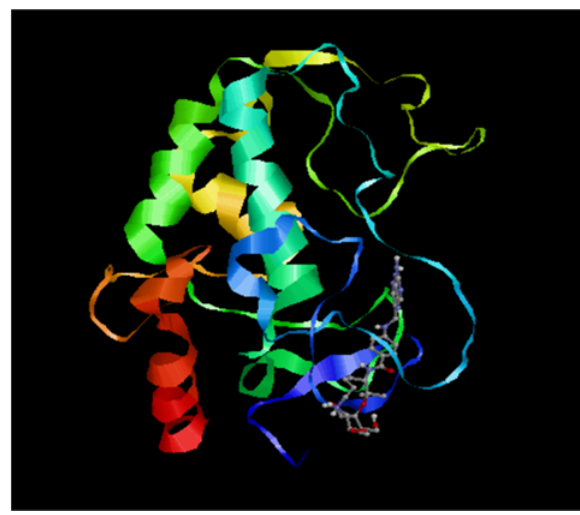
Figure 8. Receptor ‐ ligand interactions of SeChFA with the folate receptor, FOLR1. The green, turquoise, red, yellow and blue ribbons represent the the alpha and beta sheets of the respective proteins within the molecular structure of the folate receptor. The targeted nanoparticle can be seen interacting with the active site residues (blue).